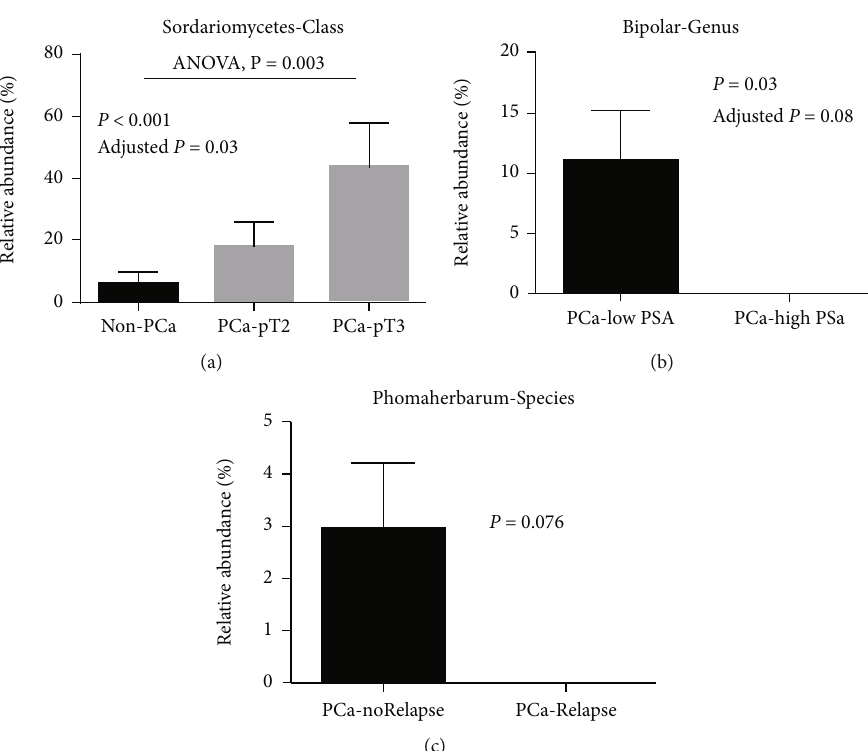
Figure 3: Associations between plasma fungal microbiome and PCa pathogenesis. (a) Increased abundance of class Sordariomycetes was observed in PCa patients with advanced stage tumor (pT3 to pT4) compared to healthy controls. (b) Enriched plasma Bipolaris genus in patients with low level of PSA compared to patients with high level of PSA. Low PSA level was identi fi ed as equal or lower than 10ng/ mL, and high PSA was identi fi ed as higher than 10ng/mL. (c) Enriched plasma Phoma herbarum species was found in patients without relapse compared to patients with relapse after two years of